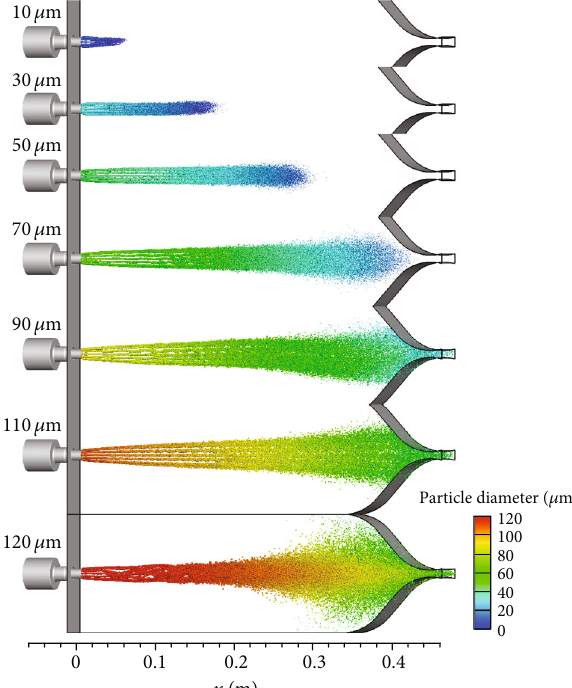
Figure 10: LOX spray trajectories of for di ff erent initial particle diameters.